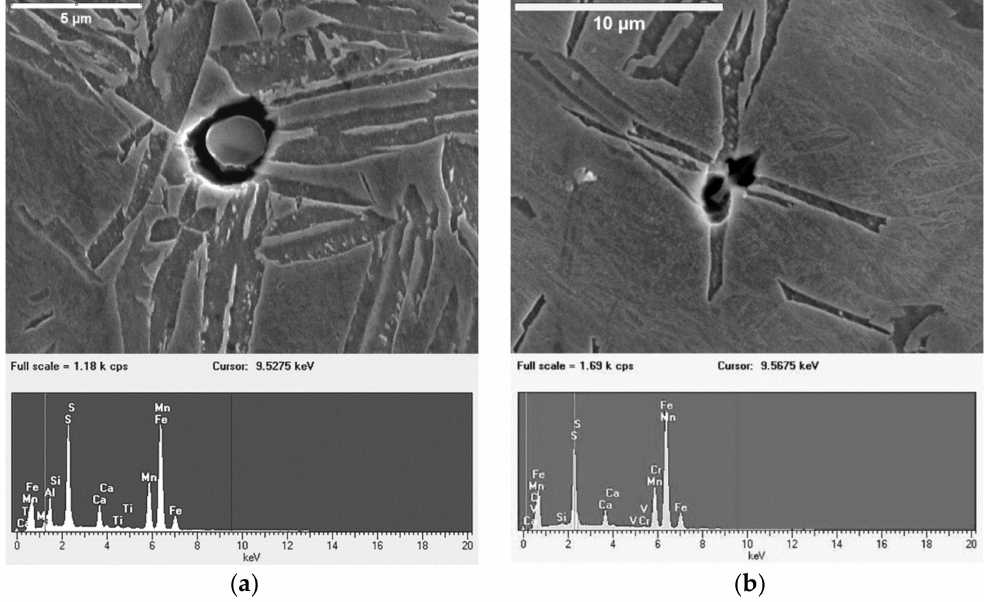
Figure 6. SEM images and EDS spectrums of the particles at which ferrite plates nucleate at: ( a ) 450 ◦ C/20 s, ( b ) at 500 ◦ C/30